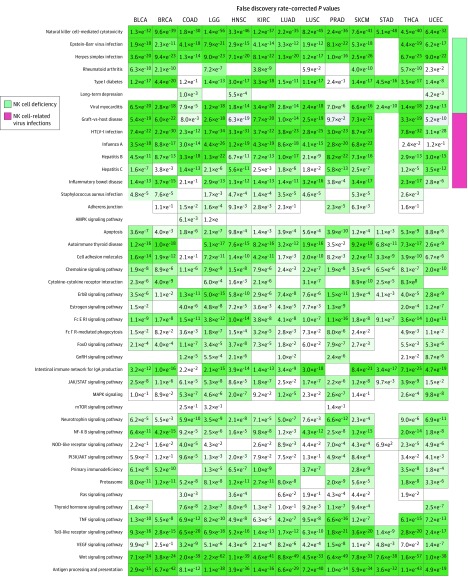
Kyoto Encyclopedia of Genes and Genomes Pathway Enrichment AnalysisHeatmap shows the enriched pathways derived from the significantly differential genes of the RNA sequenced data comparing the TIME-rich subtype with the combined TIME-intermediate and TIME-poor subtypes. Columns represent Kyoto Encyclopedia of Genes and Genomes pathways, and rows represent cancer types. BLCA indicates bladder cancer; BRCA, breast cancer; COAD, colon cancer; FoxO, forkhead box protein O; GnRH, gonadotropin-releasing hormone; HNSC, head and neck squamous cell carcinoma; JAK, Janus kinases; KIRC, renal cancer; LGG, glioma cancer; LUAD, lung adenocarcinoma; LUSC, lung squamous cell cancer; NF, nuclear factor; NOD, nucleotide-binding oligomerization domain; PI3K, phosphoinositide 3-kinase; PRAD, prostate cancer; SKCM, skin cancer; STAD, stomach cancer; STAT, signal transducer and activator of transcription protein; THCA, thyroid cancer; TNF, tumor necrosis factor; UCEC, endometrial cancer; and VEGF, vascular endothelial growth factor.